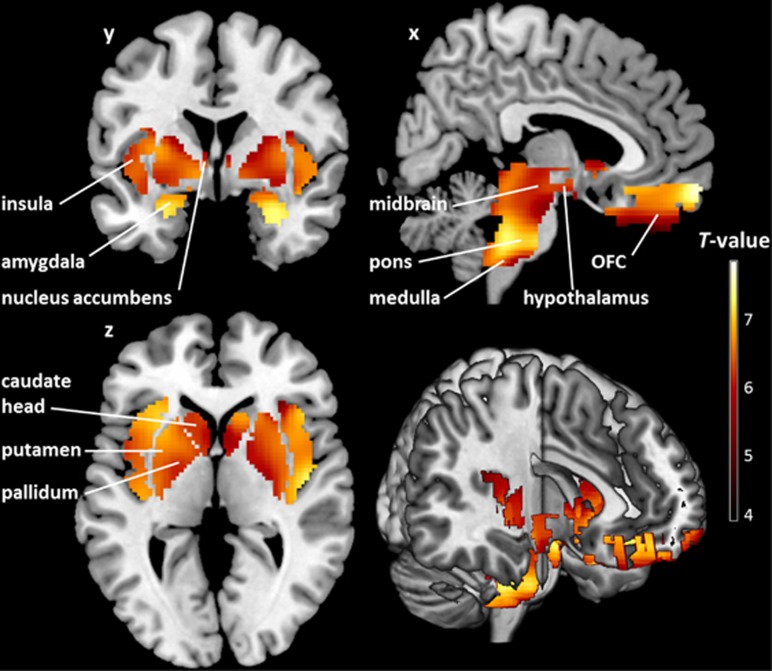
Brain regions where cannabinoid 1 receptor (CB1R) availability covaries negatively with log body mass index (BMI) in patients with food intake disorder (FID). T map of significant negative correlations between CB1R availability and log BMI in predefined homeostatic and reward-related regions of interest shown at a threshold of PFWE-corrected<0.05 (both on the voxel and cluster levels; n=54). The colored voxel-based statistical parametric mapping (SPM) results of the negative correlations in sagittal (x), coronal (y) and transverse (z) sections are overlaid on a normalized canonical image (ch2better-template) available in the MRICron software. The color bar expresses T-score levels.